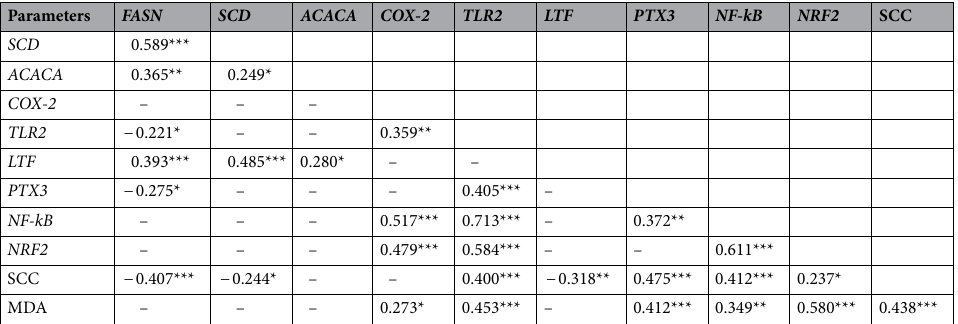
Table 2. Correlations between FASN (Fatty Acid Synthase), SCD (Stearoyl-CoA Desaturase; ACACA (Acetyl- CoA Carboxylase Alpha), COX-2 (Cyclooxygenase-2), TLR2 (Toll-like Receptor 2), LTF (Lactoferrin),